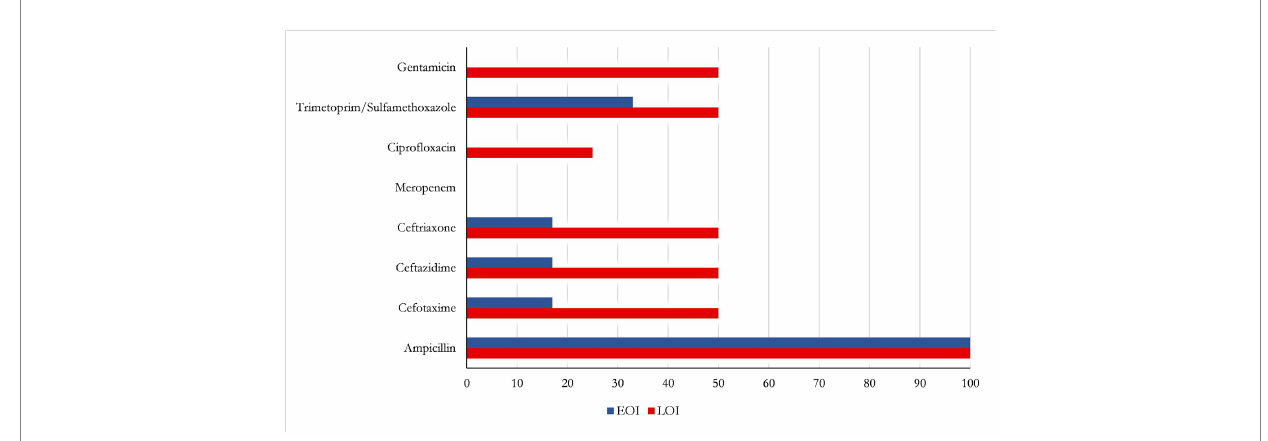
FIGURE 3 Rates of antibiotic-resistant E. coli colonizing the vagina of mothers who gave birth to infants with EOI ( N = 6; blue) or LOI ( N = 4;